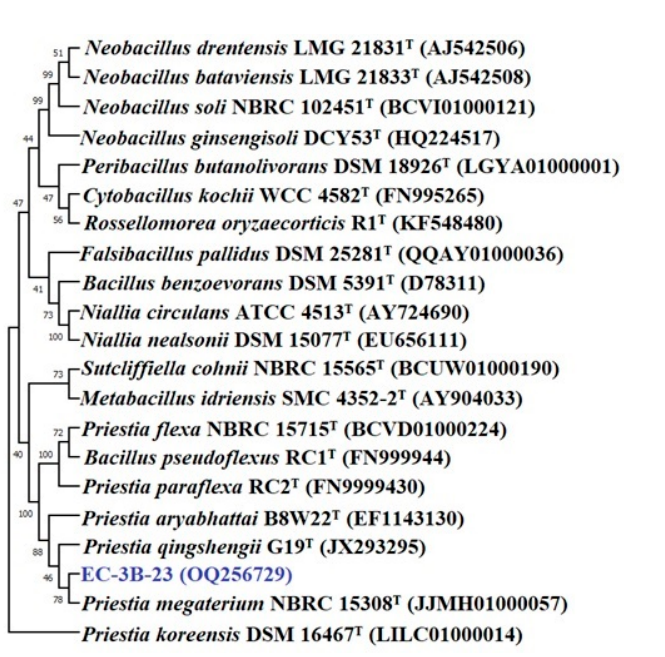
Figure 4. Phylogenetic tree of isolate Priestia sp. EC3B-23 obtained by maximum likelihood method based on the Kimura two-parameter model.